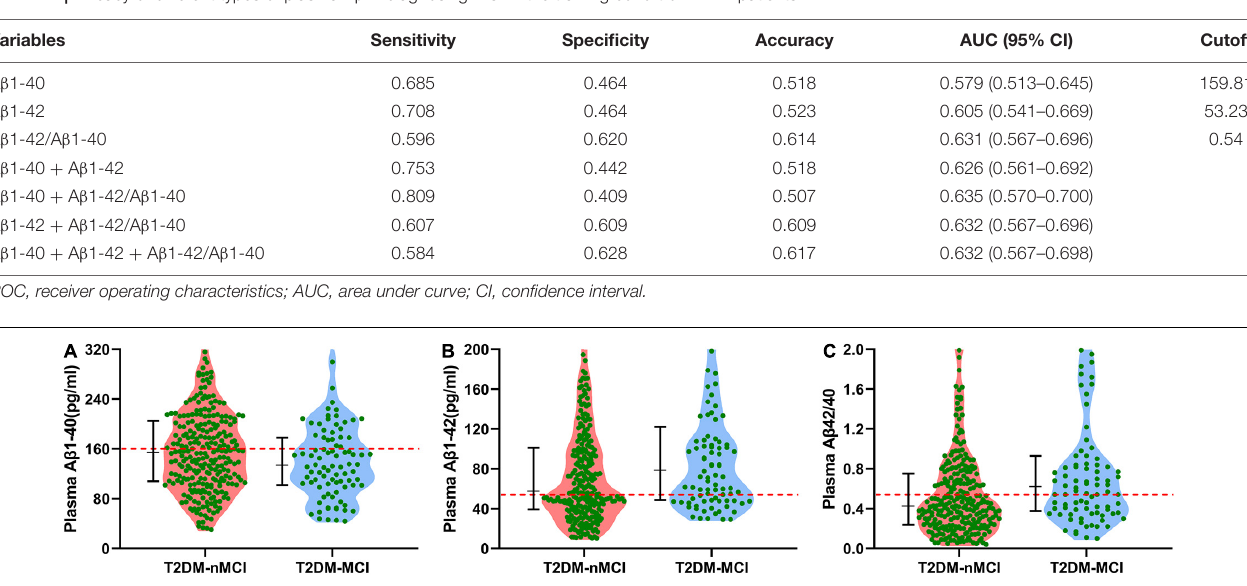
Frontiers in Cell and Developmental Biology |